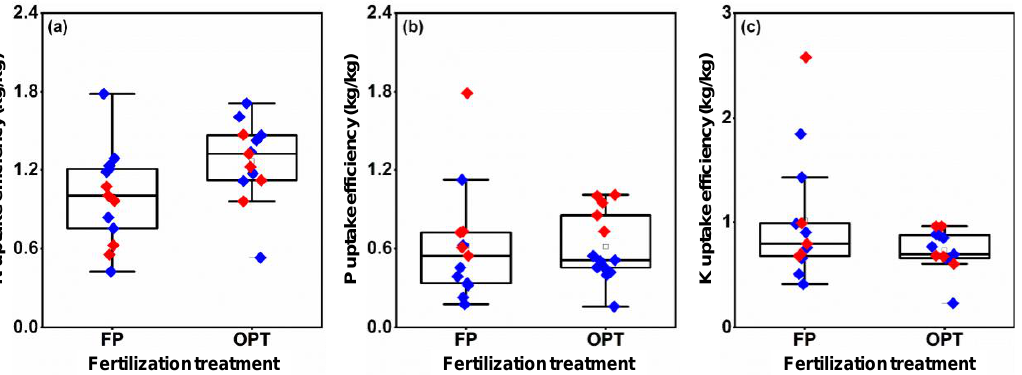
Figure 7. Uptake efficiency of N ( a ), P ( b ), and K ( c ) in peanuts under different fertilization treatments. FP: farmers’ practice fertilization; OPT: optimized fertilization. For each box plot, the top, middle, and bottom solid lines of the box represent the 75% quantile, 50% quantile, and 25% quantile, respectively; the top and bottom horizontal lines outside the box represent the 90% quantile, and 10% quantile, respectively. The square inside the box represents the mean. Blue or red diamonds: data in 2020 or 2021.